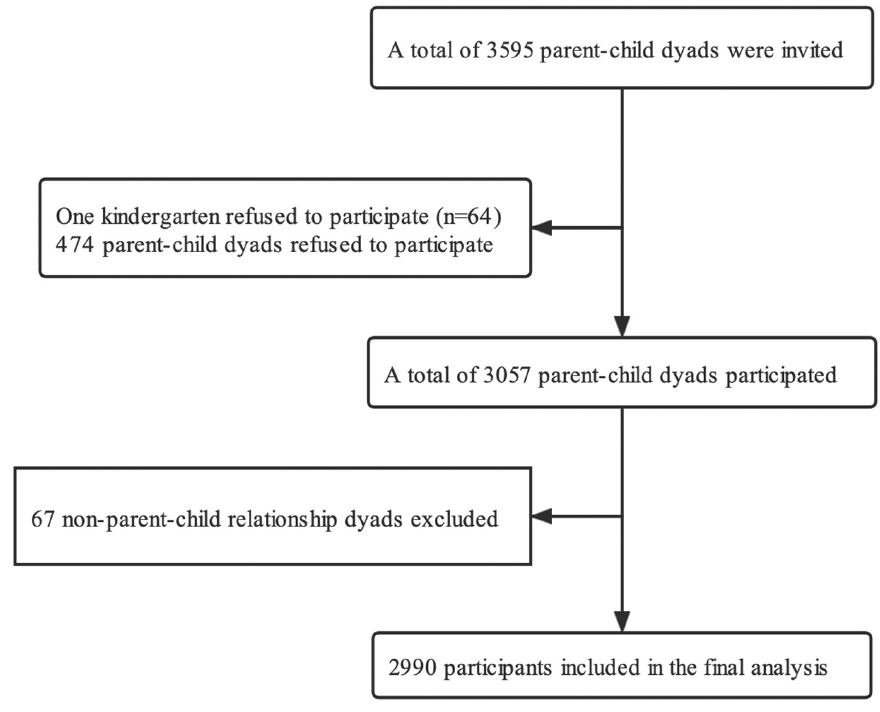
Figure 1. Flow chart of the section process of the participants. 2.2.